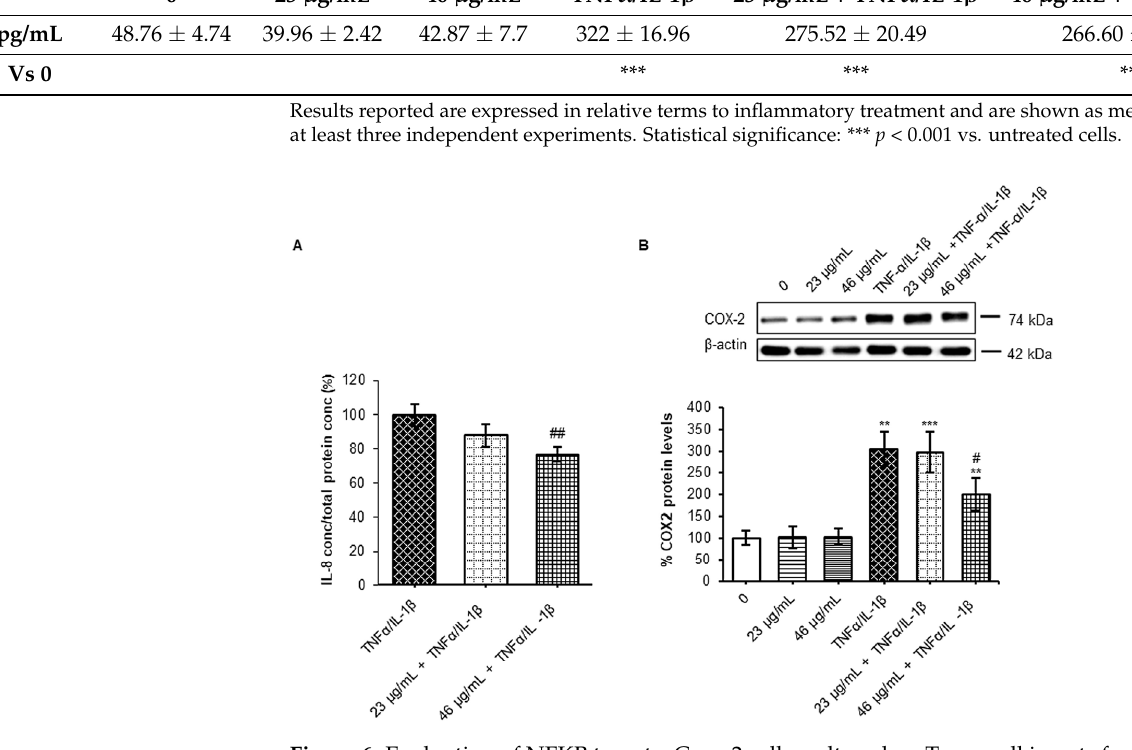
Table 2. Concentration (pg/mL) of IL ‐ 8 secreted in the basolateral media at the different conditions. 0